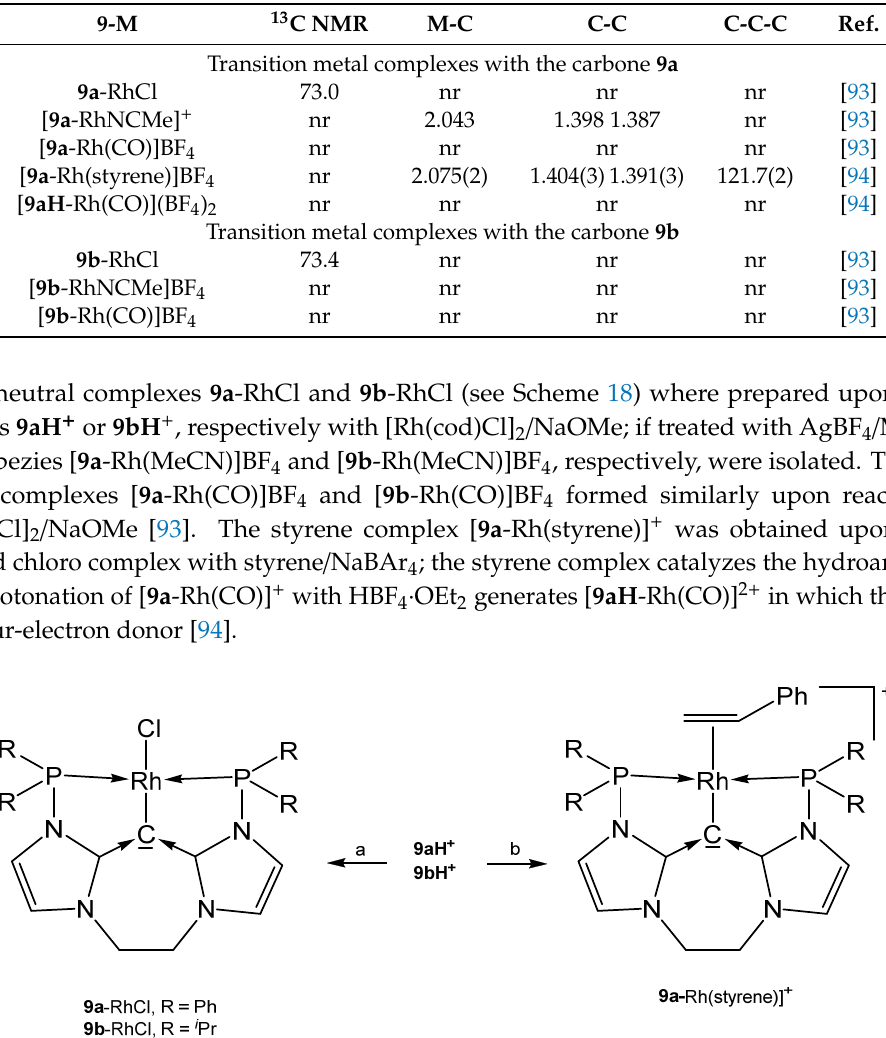
Table 9. Transition metal complexes with the carbones 9a and 9b ; 13 C NMR signal of the central donating carbon atom.